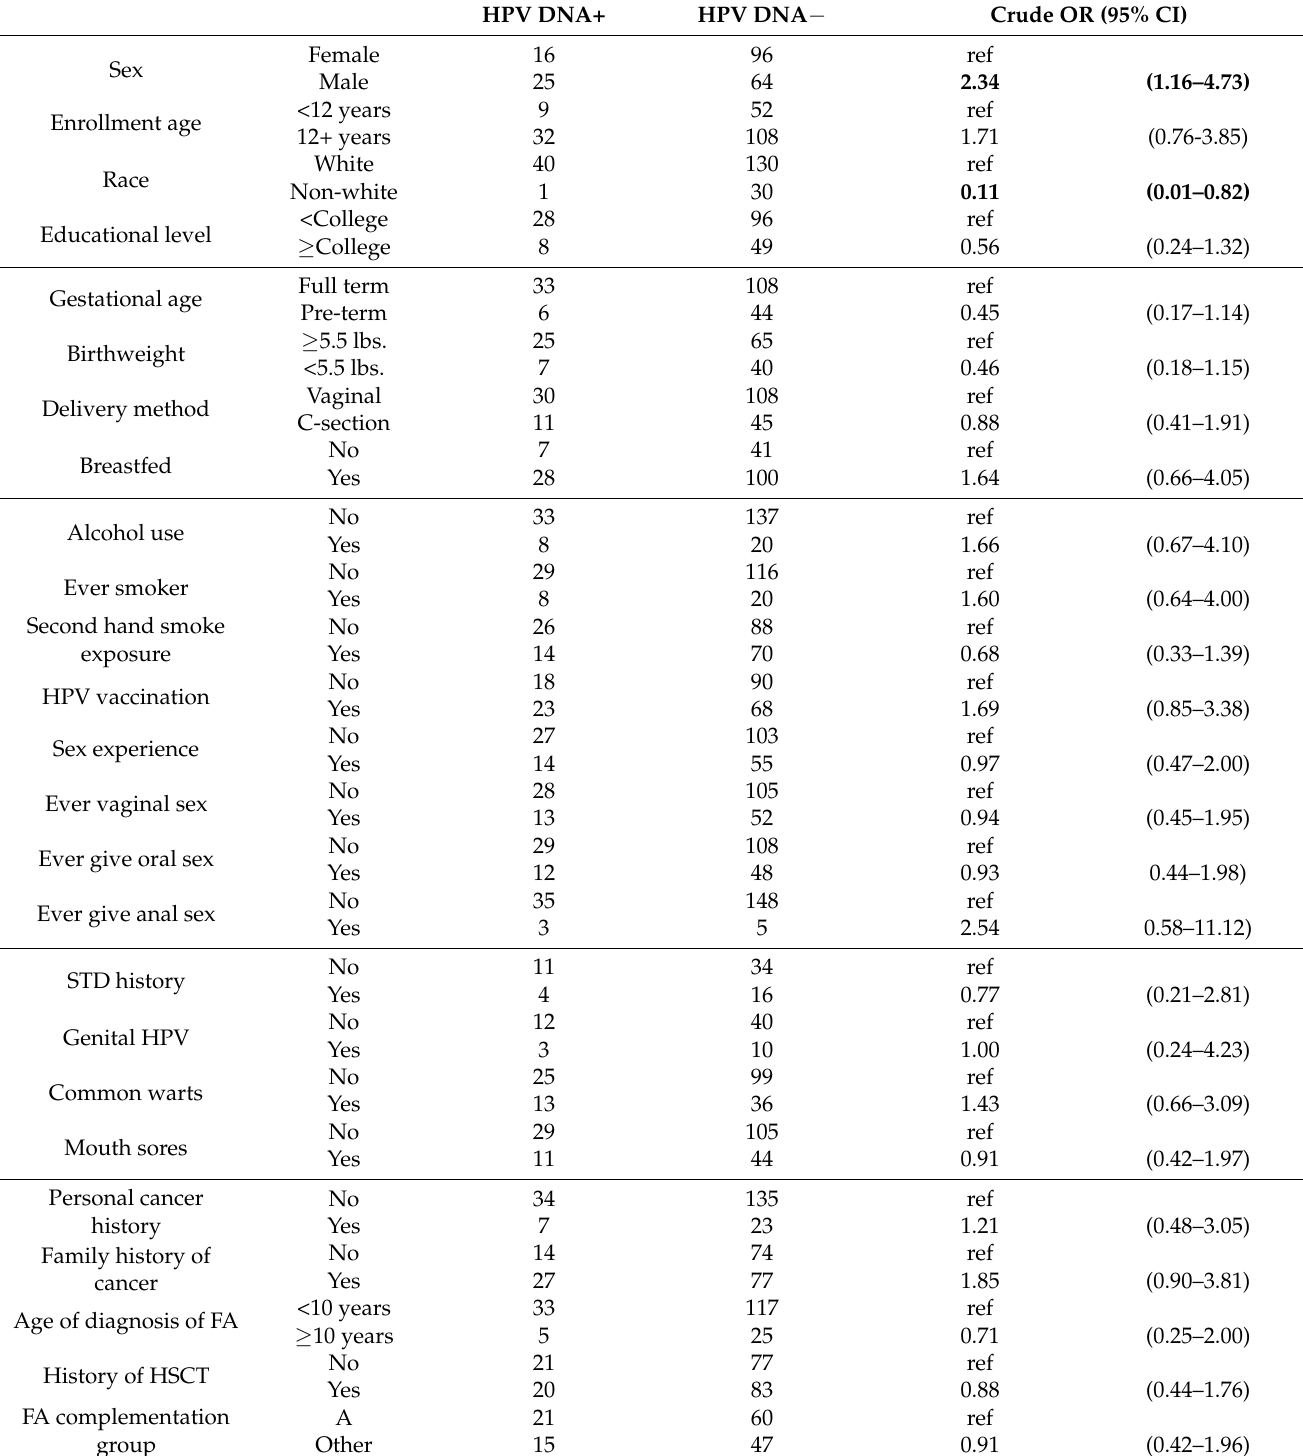
Table 5. Potential Risk Factors in Individuals with FA by Oral HPV DNA